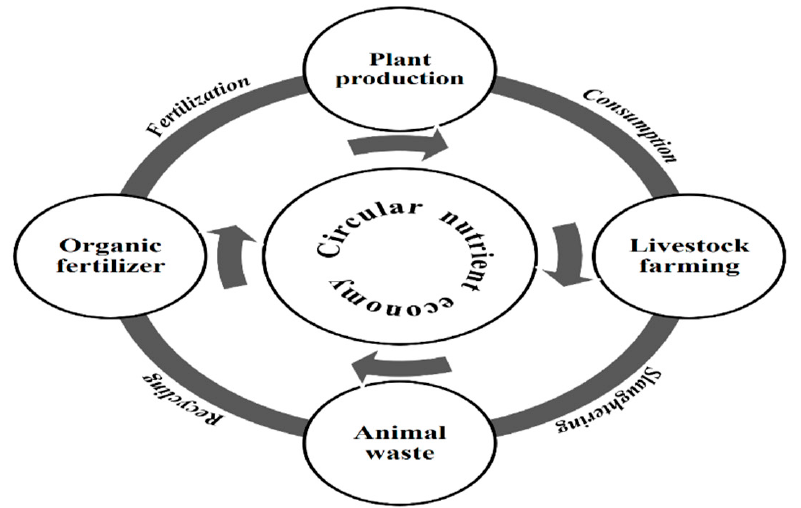
Figure 3. Circular nutrient economy and its elements.